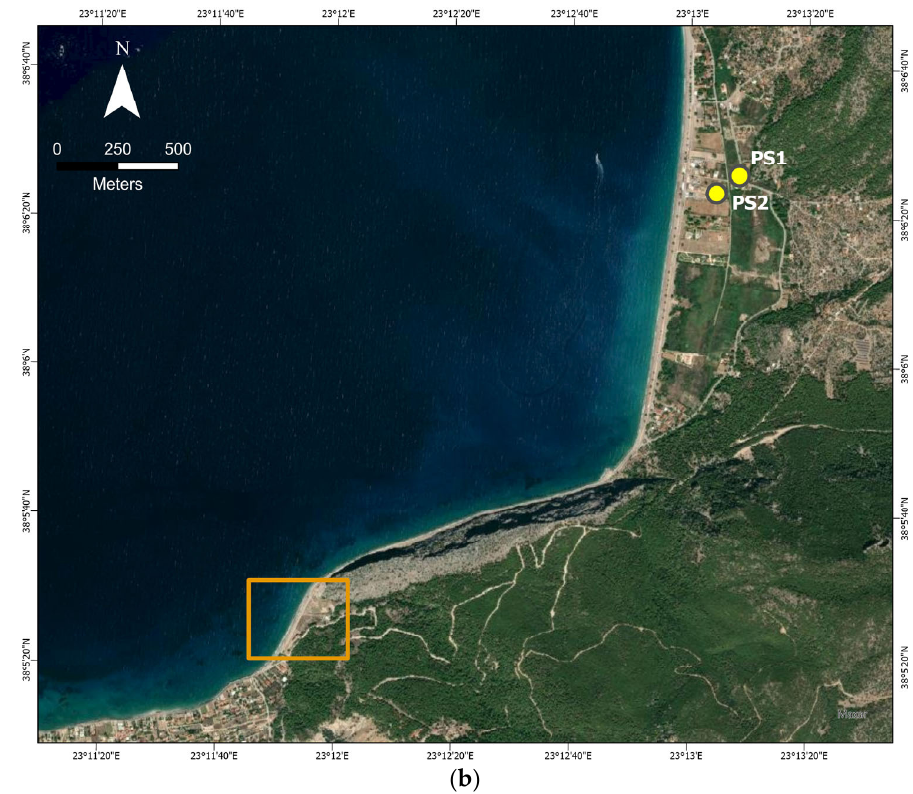
Figure 1. ( a ) Tectonic setting of the study area. The yellow box shows the location of the Psatha area. The green circles show the epicenters and magnitudes of the 1981 earthquakes; ( b ) location of cores PS1 and PS2 and studied beachrocks (yellow box).